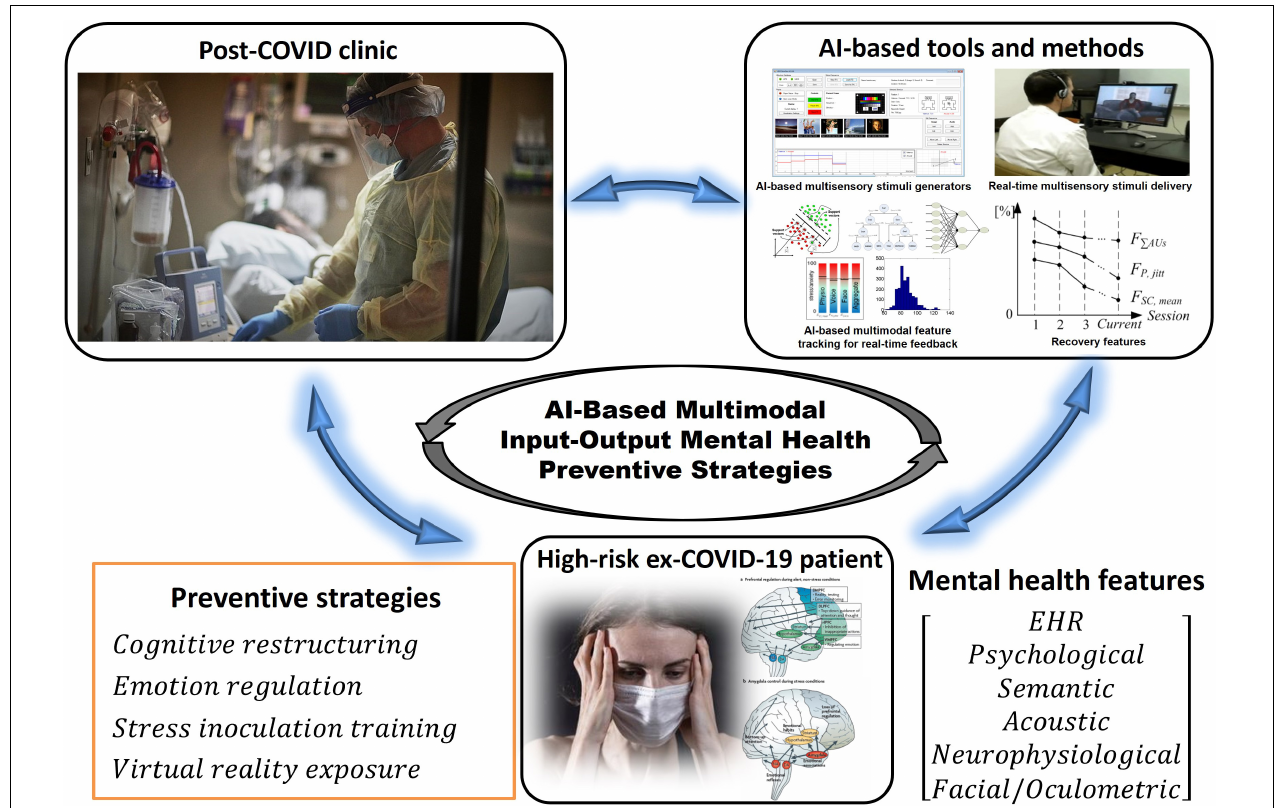
FIGURE 3 | Concept of the integration of AI-based tools and methods with various preventive intervention